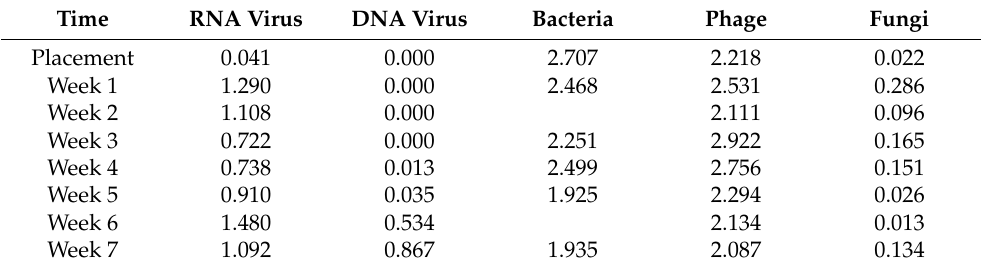
Figure 5. Phylogenetic tree of ( A ) virus, ( B ) bacteria, ( C ) bacteriophage and ( D ) yeast and fungi. Node diameter indicates average abundance at species ( A , C , D ) and genera ( B ) level. Taxonomic levels range from phylum to genera ( B ), order to species ( C ) phylum to species ( D ). Viruses ( A ) are organized according to structural classification. Table 2. Shannon diversity of respiratory microbes in a healthy broiler flock over time.—no